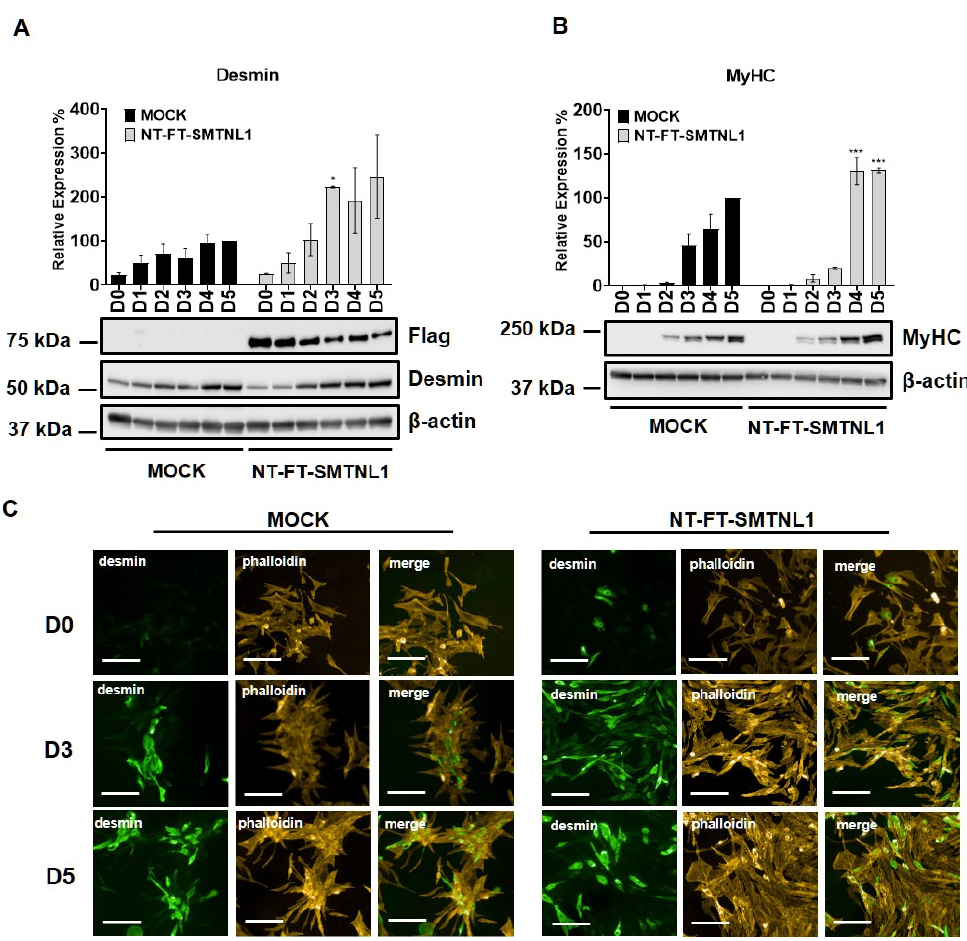
Figure 1. Effect of SMTNL1 overexpression on desmin and MyHC expression during myogenesis. Lysates from NT-FT-SMTNL1 or empty vector-transfected differentiated C2C12 cells were analyzed using Western blot with antibodies specific for early and late differentiation markers desmin ( A ) and MyHC ( B ), respectively. Transfection efficiency was determined using immunoblotting with anti-Flag antibody. Values represent n = 3, mean ± SEM. Differences between group means were determined using Two-way ANOVA followed by Sidak multiple comparisons post hoc test, p < 0.05 (*), p < 0.001 (***). ( C ) Immunofluorescent staining of cells at Day 0, Day 3 and Day 5 of differentiation after transfection with empty vector or NT-FT-SMTNL1. For staining, anti-desmin antibody (green) and Texas-Red Phalloidin (red) were used. Fluorescent signals were detected using an automated high-content screening instrument. Scale bars: 500 µm.